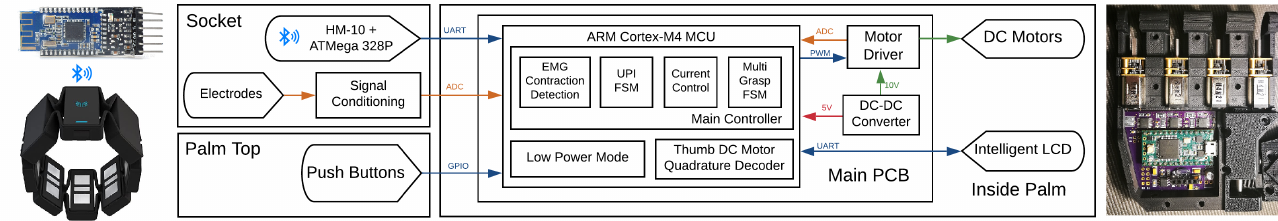
Figure 2. System block diagram showing the embedded controller architecture and the integration with external